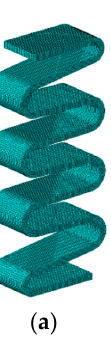
Figure 5. Stiffness simulation results for different mesh sizes.